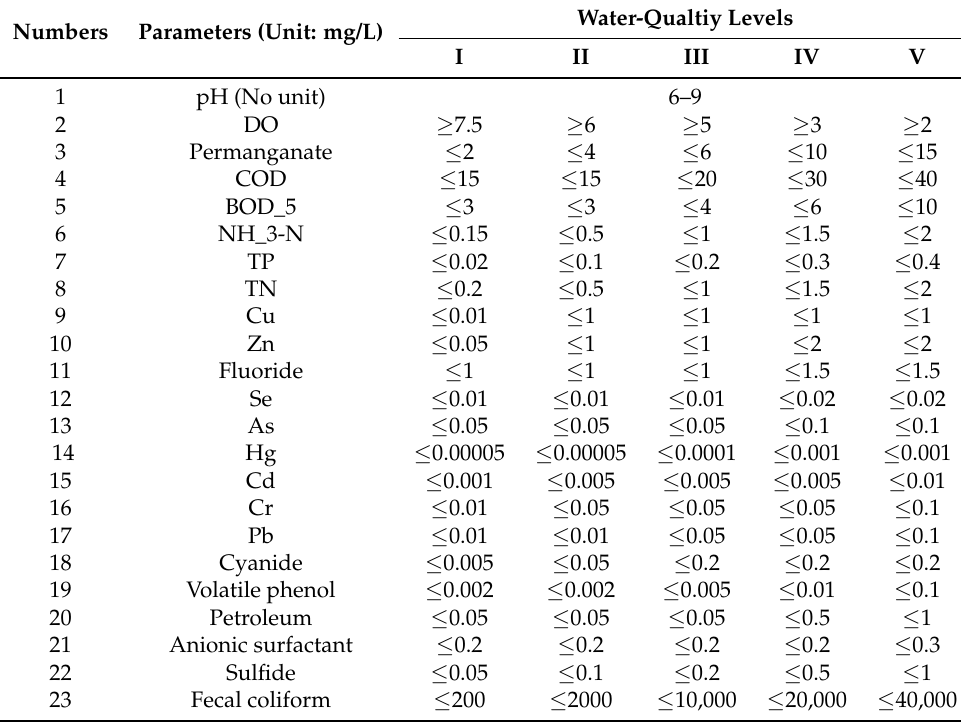
Table A1. Classification standards of water-quality levels in